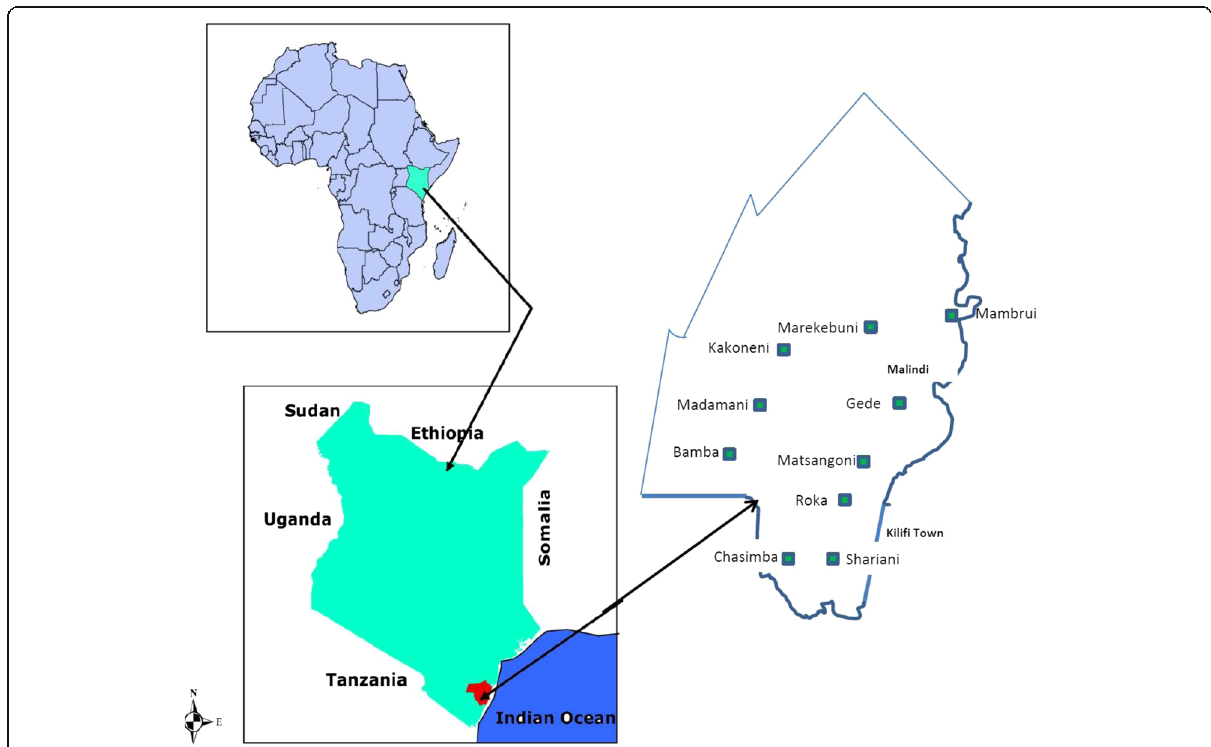
Fig. 1 Geographical map og kilifi County showing the sub-locstions across the five